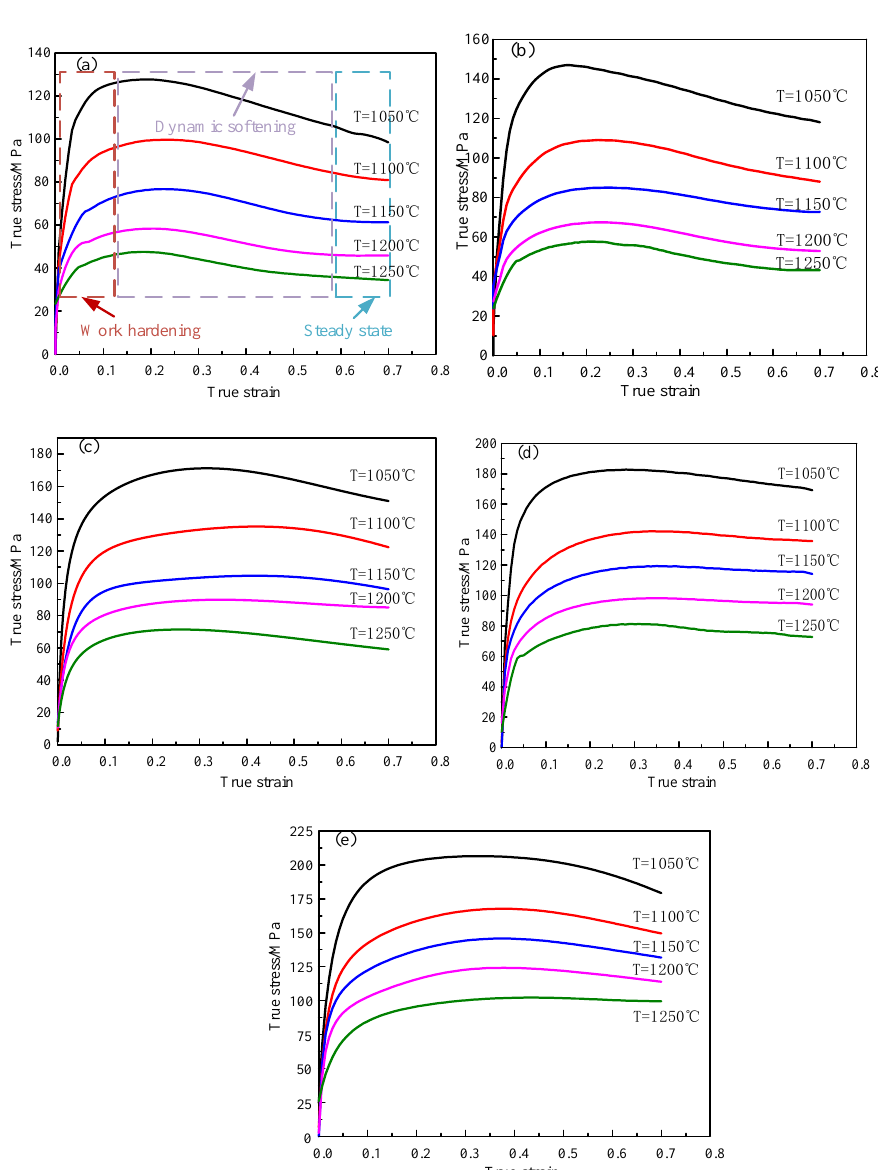
Figure 2. True flow stress curves of X12 ferritic heat-resistant steel under various deformation conditions: ( a ) ε = 0.05 s − 1 ; ( b ) ε = 0.1 s − 1 ; ( c ) ε = 0.5 s − 1 ; ( d ) ε = 1 s − 1 ; ( e ) ε = 5 s − 1